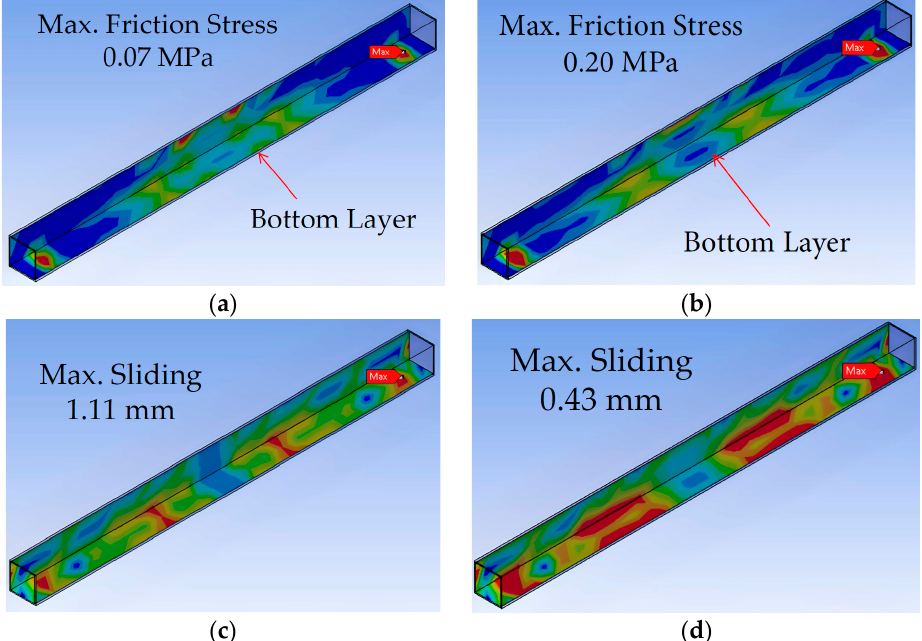
Figure 3. Maximum stress and sliding distance overtime of the hybrid beams; ( a ) NB-CL40 Beam;